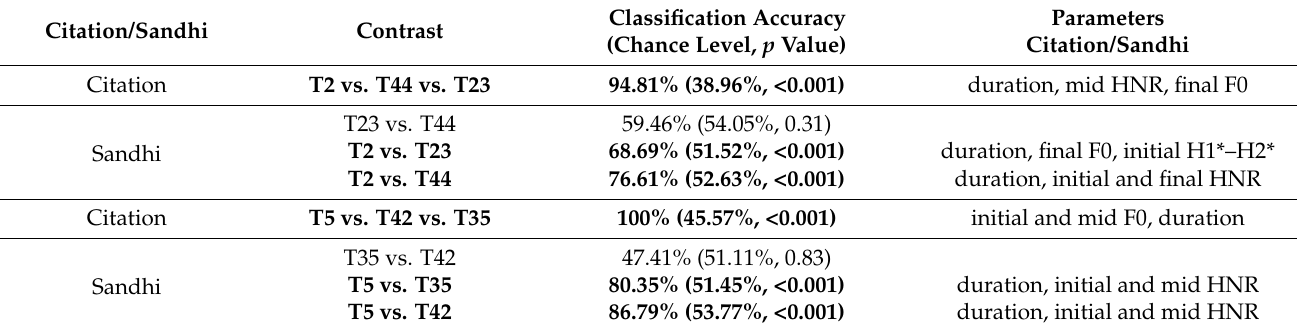
Table 9. Classification accuracies and top three parameters that have the highest correlation with LD1 (Contrasts that are differentiated significantly above chance are in bold).